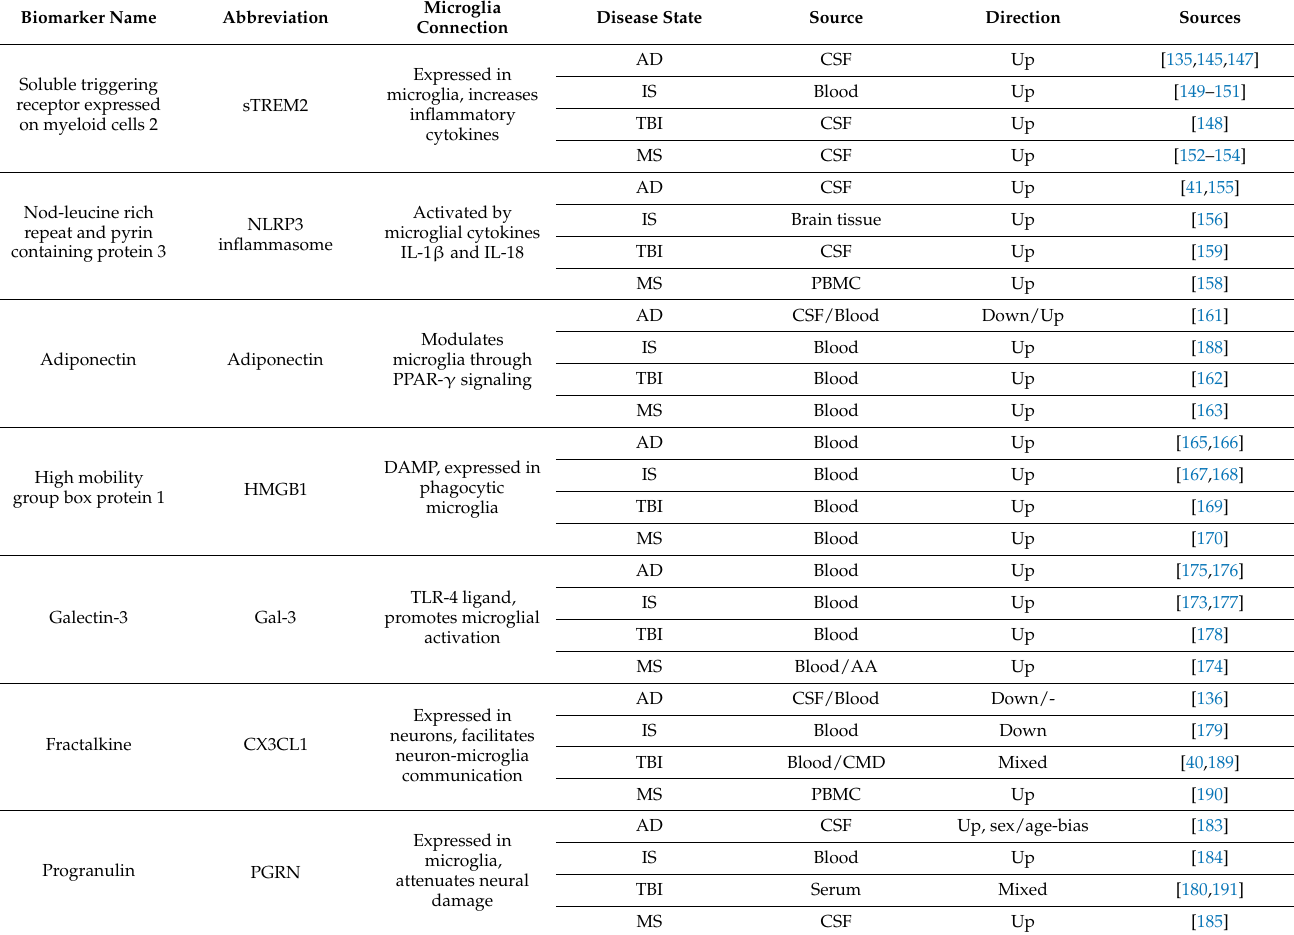
Table 2. Blood/CSF biomarkers targeting microglia in AD, IS, TBI, and